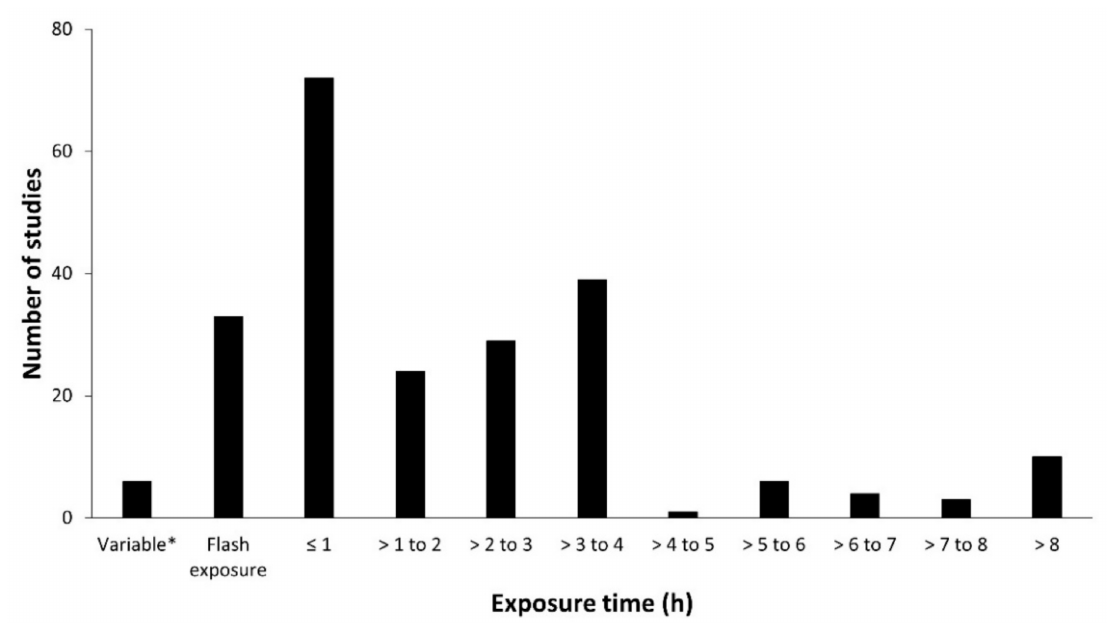
Figure 6. Number of studies binned according to the exposure time they used. * Uses different exposure times in the